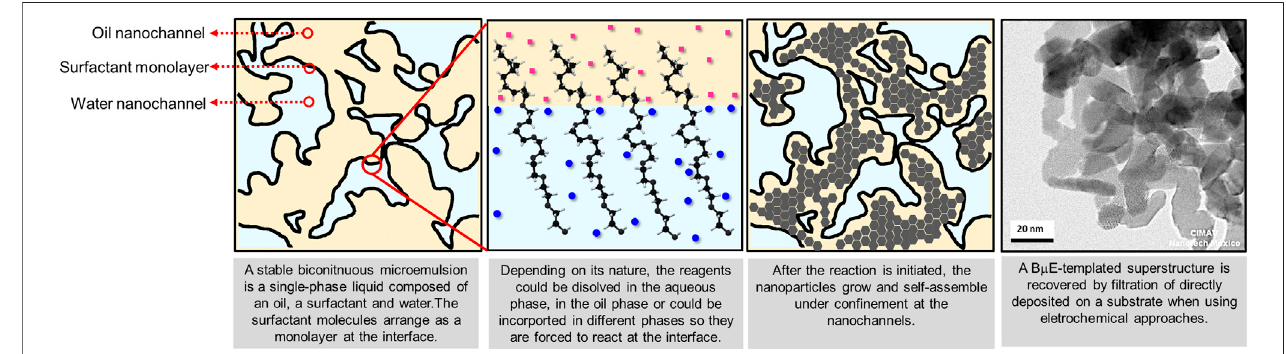
FIGURE 1 | Schematic representation of the template effect of a B μ E. A surfactant monolayer separates the water and oil nanochannels. Depending on their chemical nature, the reagents may be incorporated in different combinations (aqueous phase, oil phase, or both). The fi nal HSS can be quickly recovered from the liquid